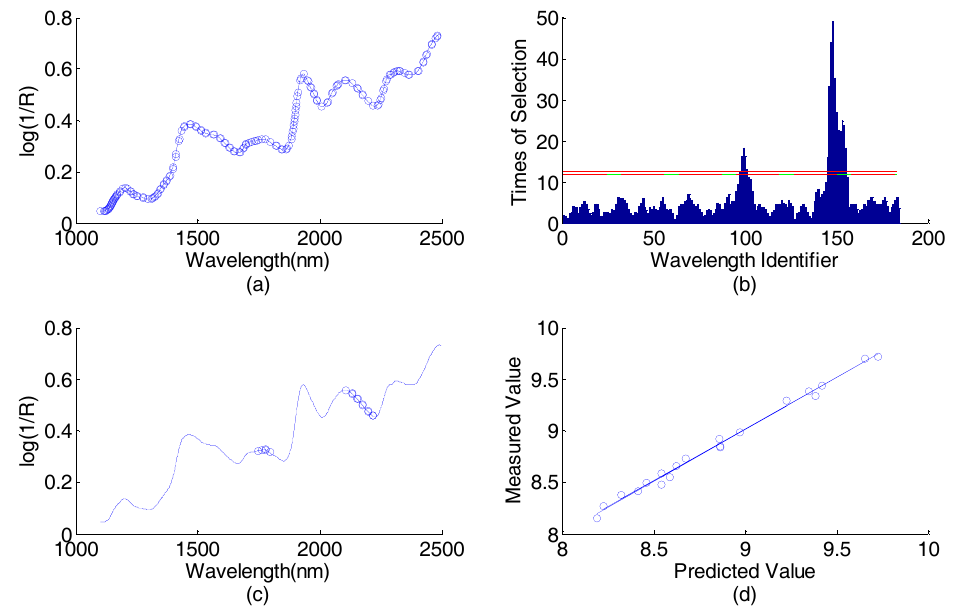
Figure 4. Corn data (predicting protein content) wavelength selection result by using AP-PN-GA-PLS in the first round: ( a ) spectral responses vs. wavelengths, the 184 wavelengths selected by AP-PN are marked with circles; ( b ) times of selection (by GA-PLS) vs. wavelength identifier (1–184), the wavelengths above the lower line were selected; ( c ) spectral response vs. wavelengths, the 16 wavelengths selected by AP-PN-GA-PLS are marked with circles; ( d ) scatter plot of predicted values vs. the measured values. PLS = partial least square; GA = genetic algorithm.